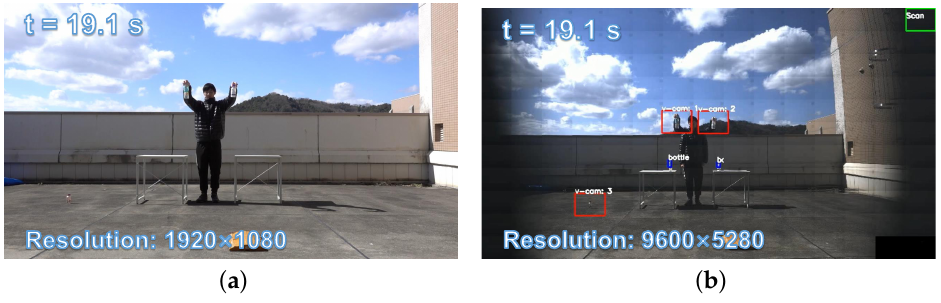
Figure 10. The 1920 × 1080 input images from the digital camera and panoramic stitched 9600 × 5280 images from the PTZ camera: ( a ) input image of digital camera and ( b ) panoramic stitched image from the PTZ